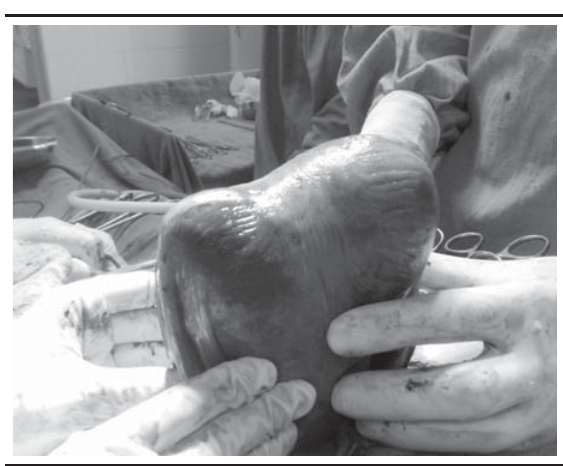
Figure 1. Indentation over the fundus of the uterus